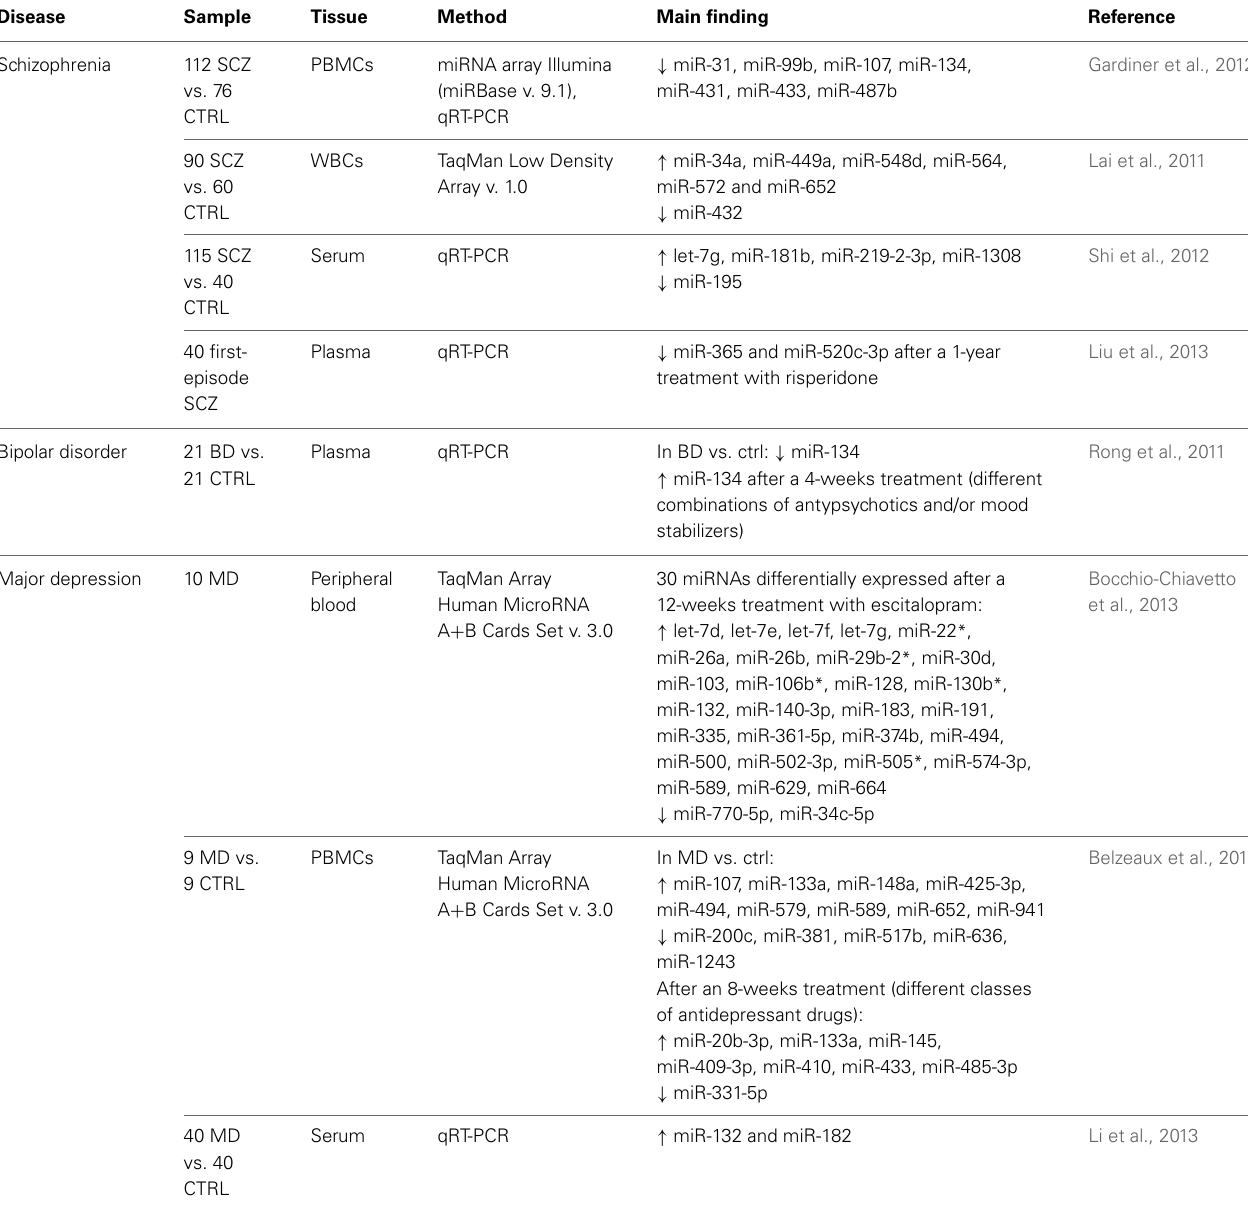
Table 1 | microRNA expression studies in psychiatric disorders.